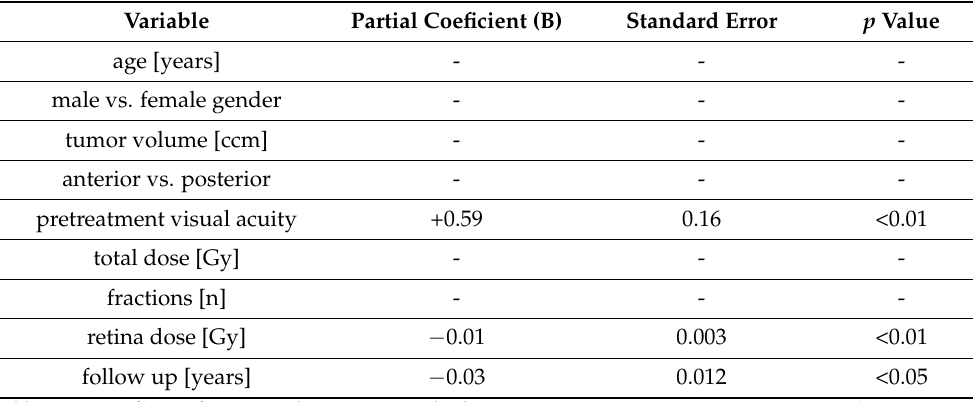
Table 3. Multivariate analysis of pretreatment epidemiological and clinical findings regarding favorable visual